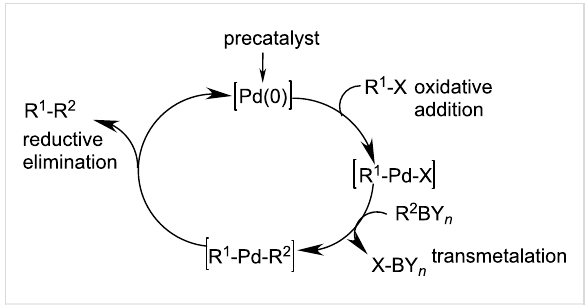
Scheme 10: A representative palladium catalytic